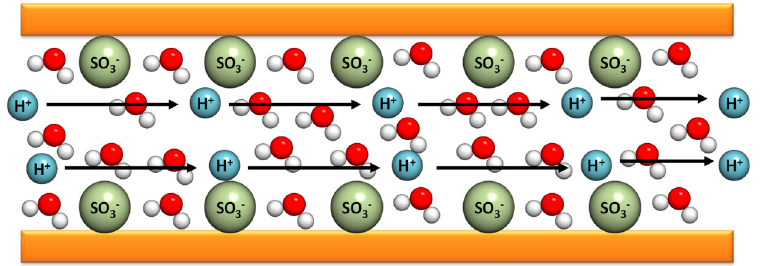
Figure 6. Schematic representation of the vehicular mechanism in a polymeric membrane.